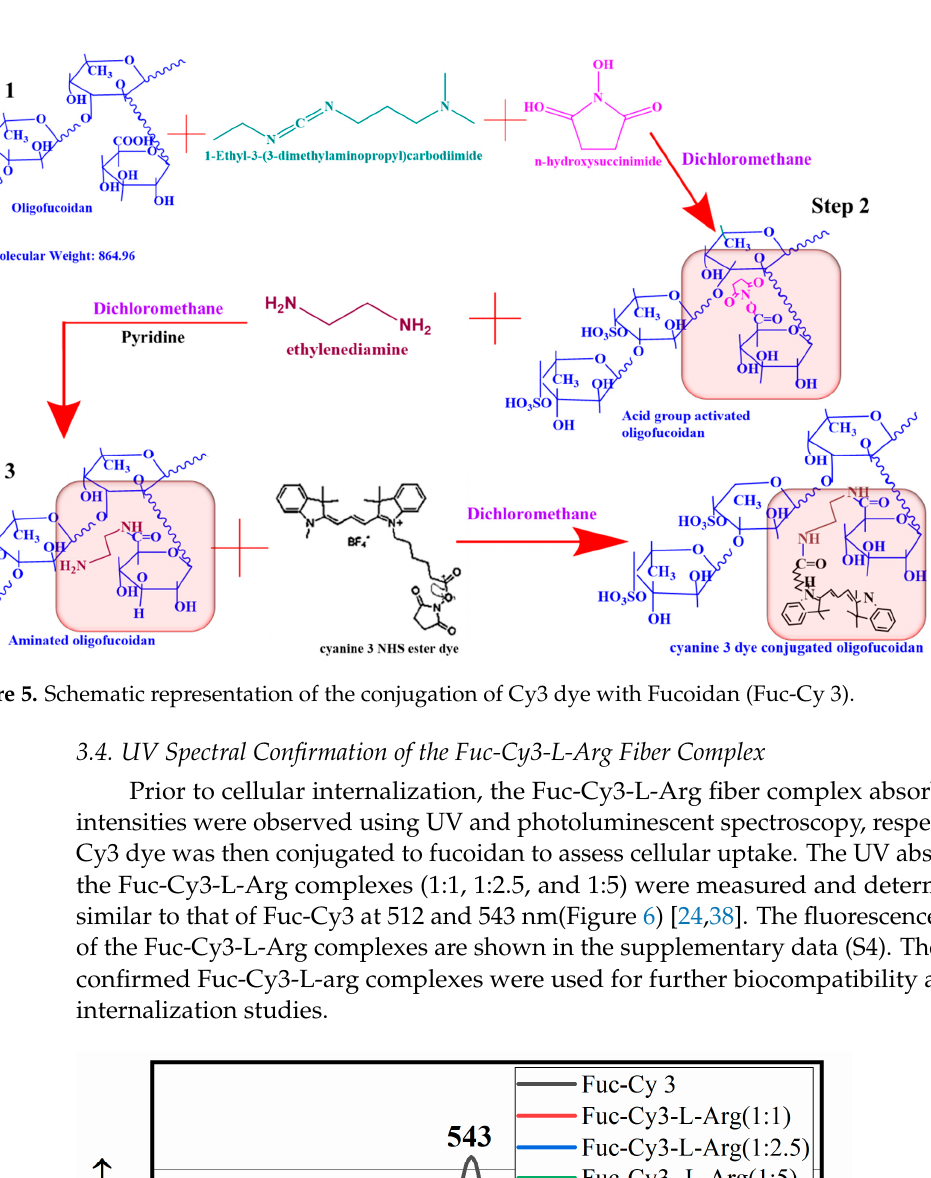
Figure 4. ( a ) UV absorbances of the Cy3 NHS ester and Fuc-Cy3 dyes, ( b ) two-dimensional fluorescence intensities of the Cy3 NHS ester and Fuc-Cy3 dyes, ( c ) three-dimensional fluorescence intensity of the Cy3 NHS ester dye, ( d ) three-dimen-